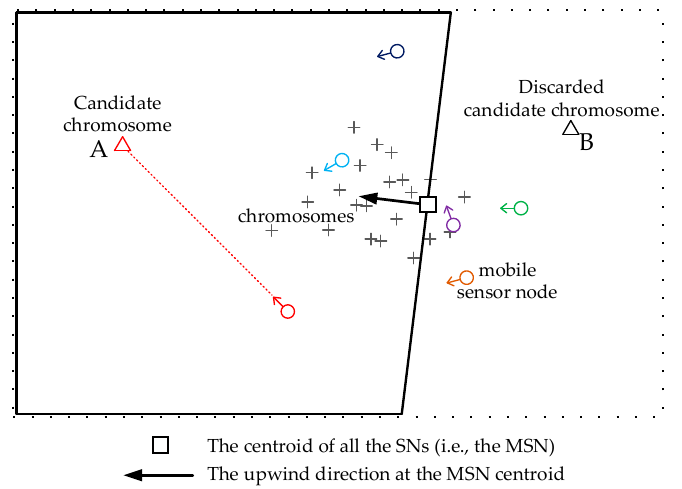
Figure 3. The illustration of the customized crossover operator. The polygon with solid borderlines and the rectangle with dotted borderlines are the upwind search area and the whole search area, respectively.